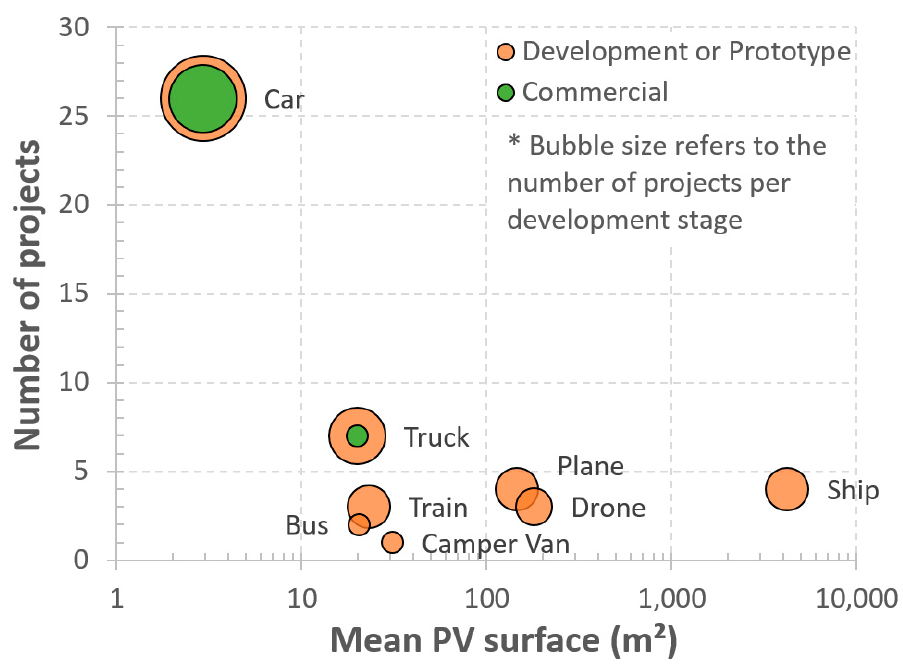
Figure 2. Number of initiatives for several vehicle types and their development stage.